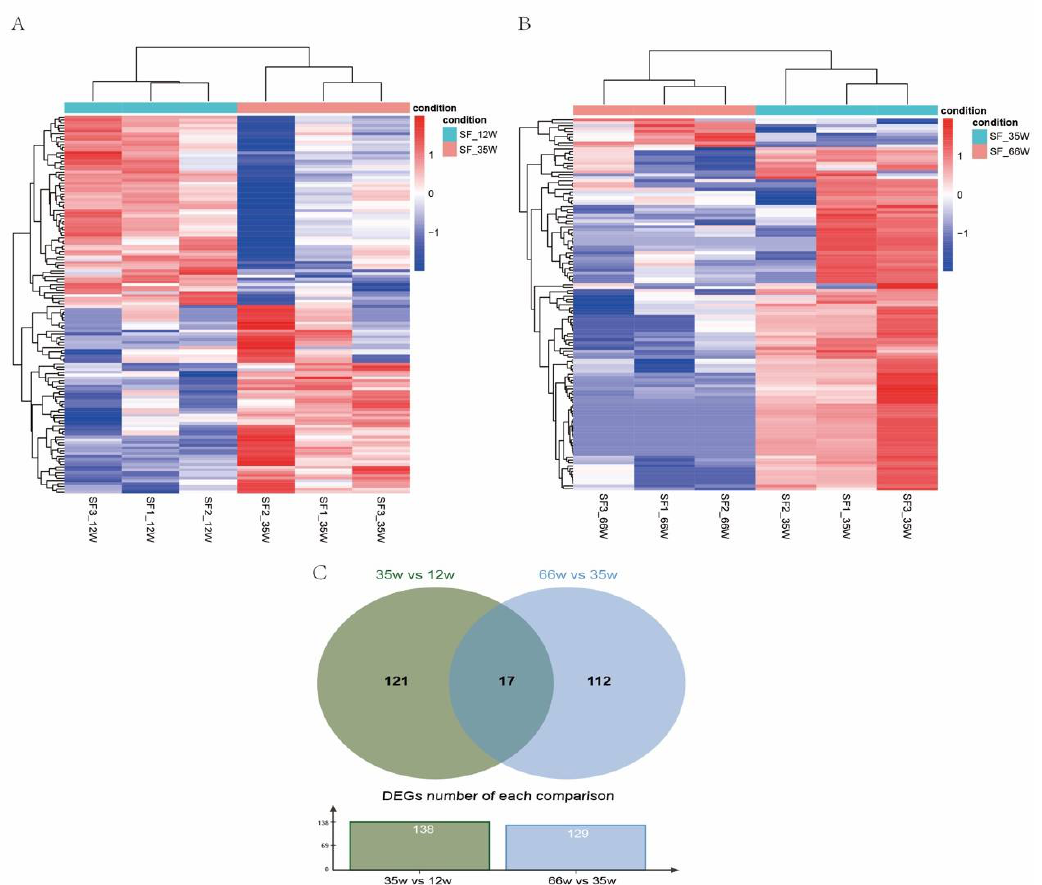
Figure 1. Differentially expressed genes (DEGs) of Muscovy duck subcutaneous fat (SF) at different developmental stages. ( A ). Hierarchical clustering analyses were performed based on DEGs between 35 and 12 weeks. ( B ). Hierarchical clustering analyses were performed based on DEGs between 66 and 35 weeks. ( C ). Venn diagram of DEGs at different developmental stages.